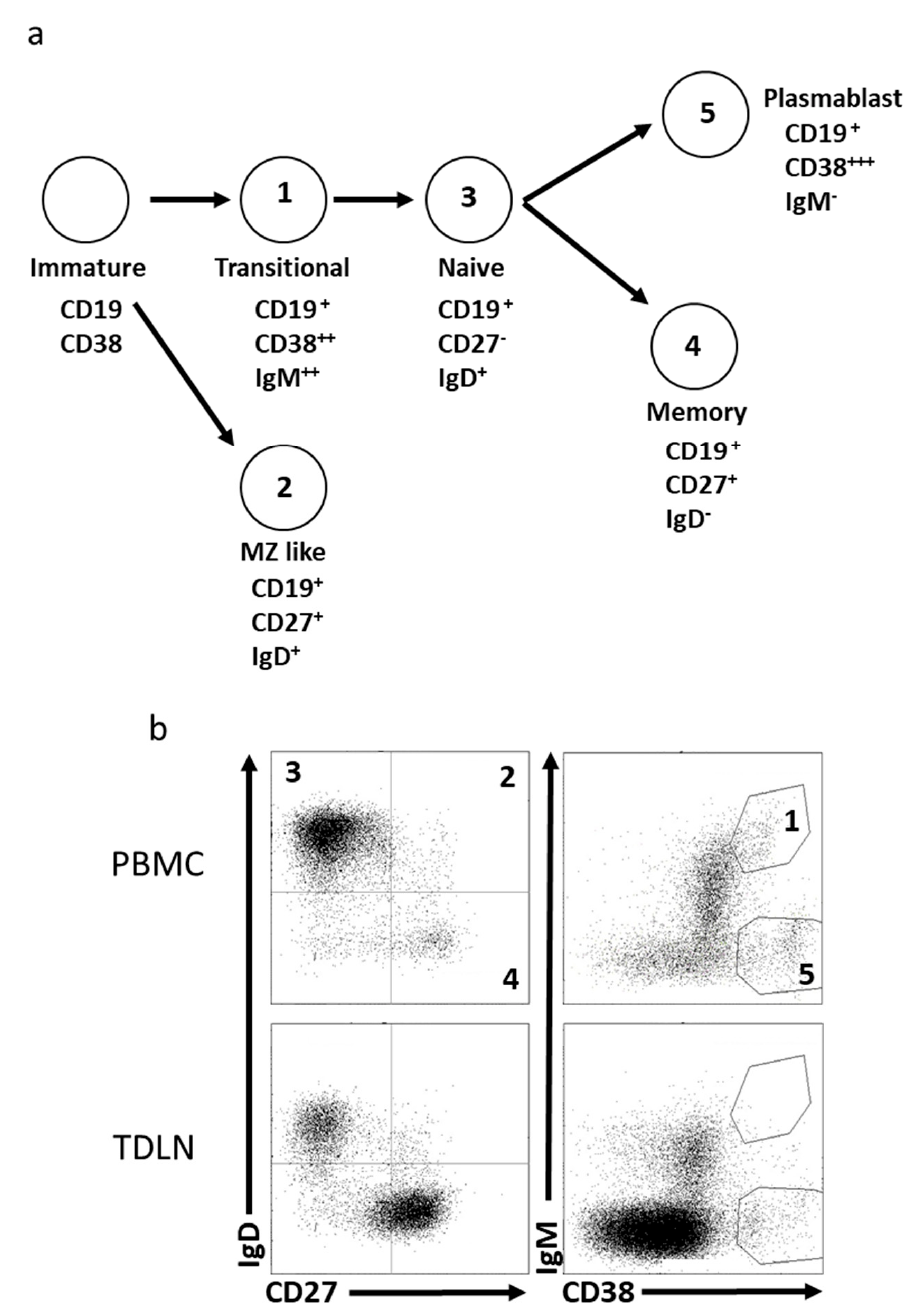
Figure 1. Representative gating strategy using the Freiburg panel. The B cells can be divided into five subpopulations based on expression of surface markers ( a ). Gating strategy revealing the five subpopulations. The numbers correspond to different subpopulations ( b ). All cells are gated on live CD19 + cells.